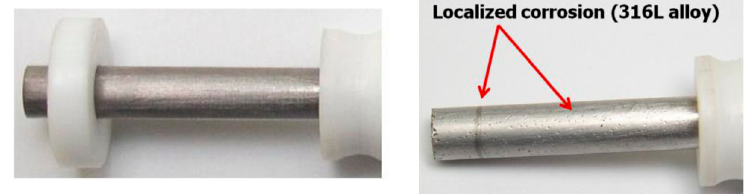
Figure 4. Sample used for the crevice corrosion tests.